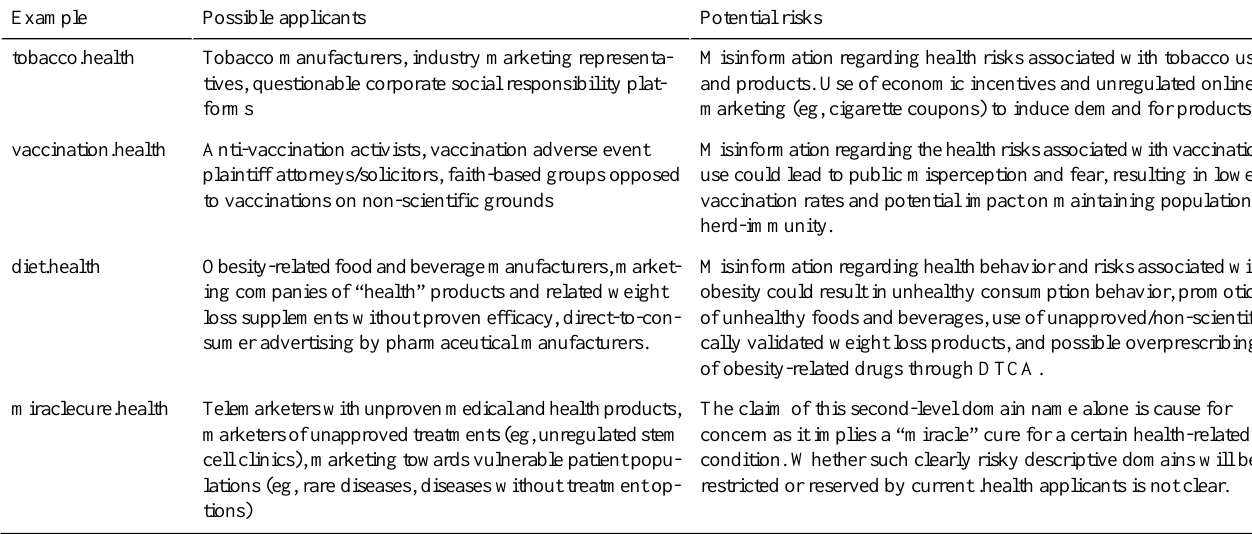
Table 2. Examples of potential misuse of .health second-level domain